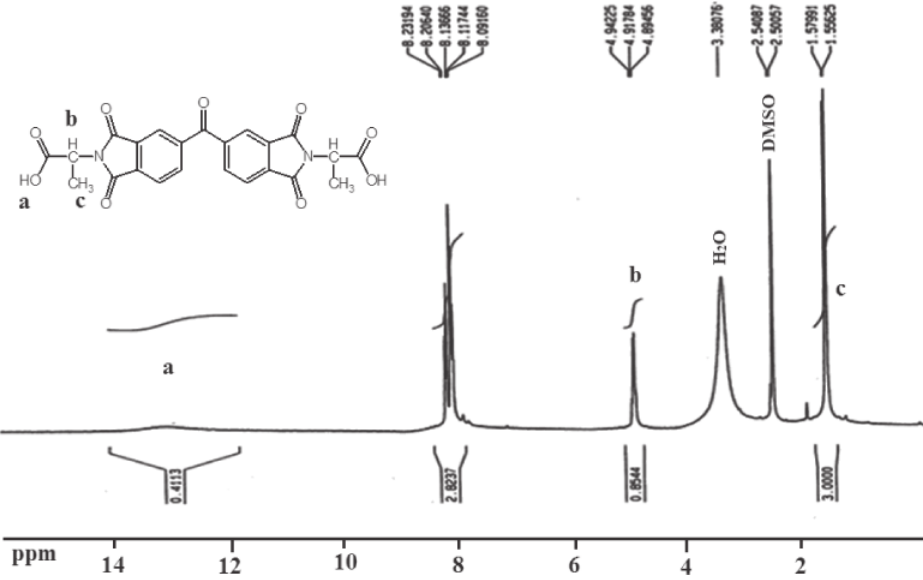
Fig. 3: 1 H-NMR spectrum of diimide-diacid 7a